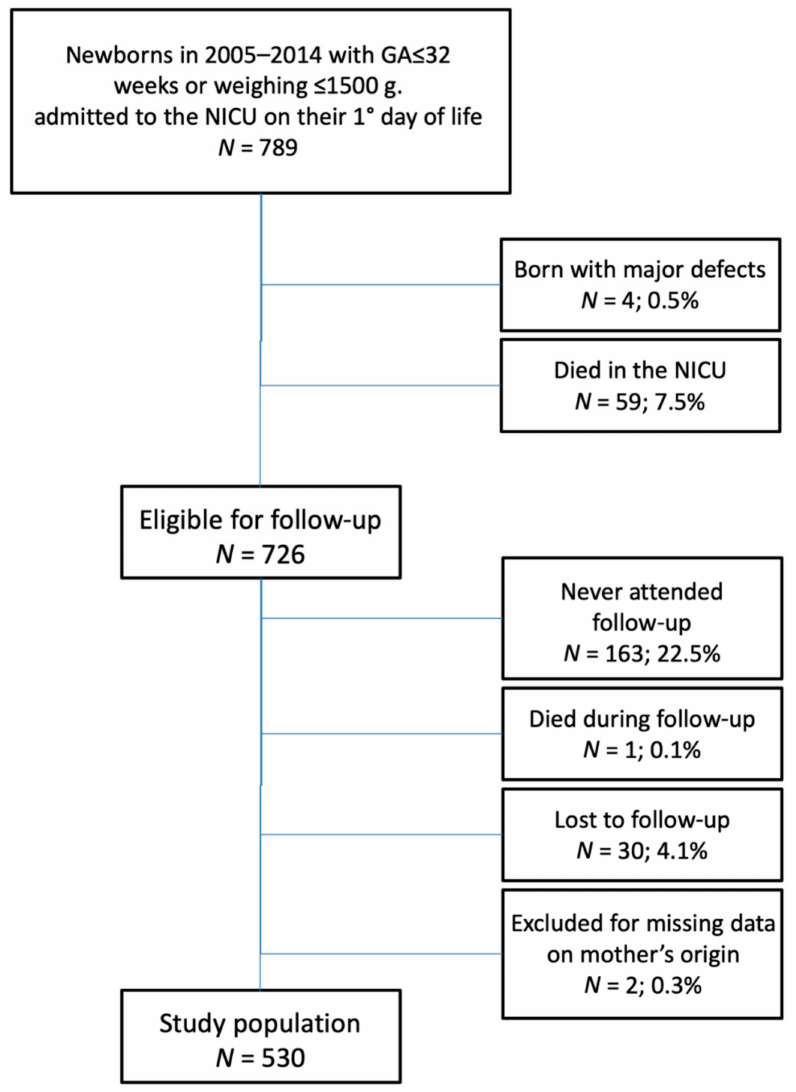
Figure 1. Flow chart of the study population. GA, gestational age; NICU, neonatal intensive care